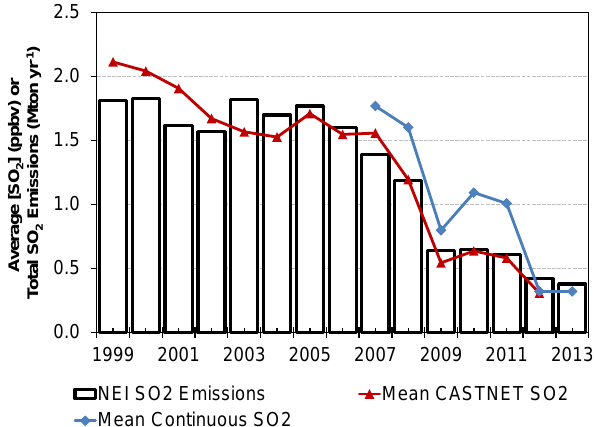
Figure 4. Comparison of annual SO 2 concentrations at Look Rock with corresponding total SO 2 emissions in the Look Rock domain.